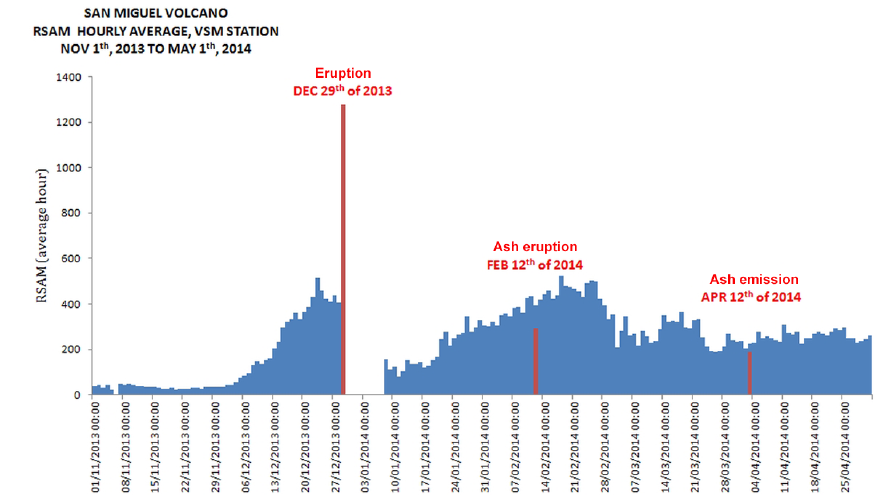
Figure 5. Eruption of 29 December 2013 and small explosions. The blue lines show the RSAM (Real-time Seismic Amplitude Measurement) behavior during 2014 and the first days of 2015. Units are in counts.